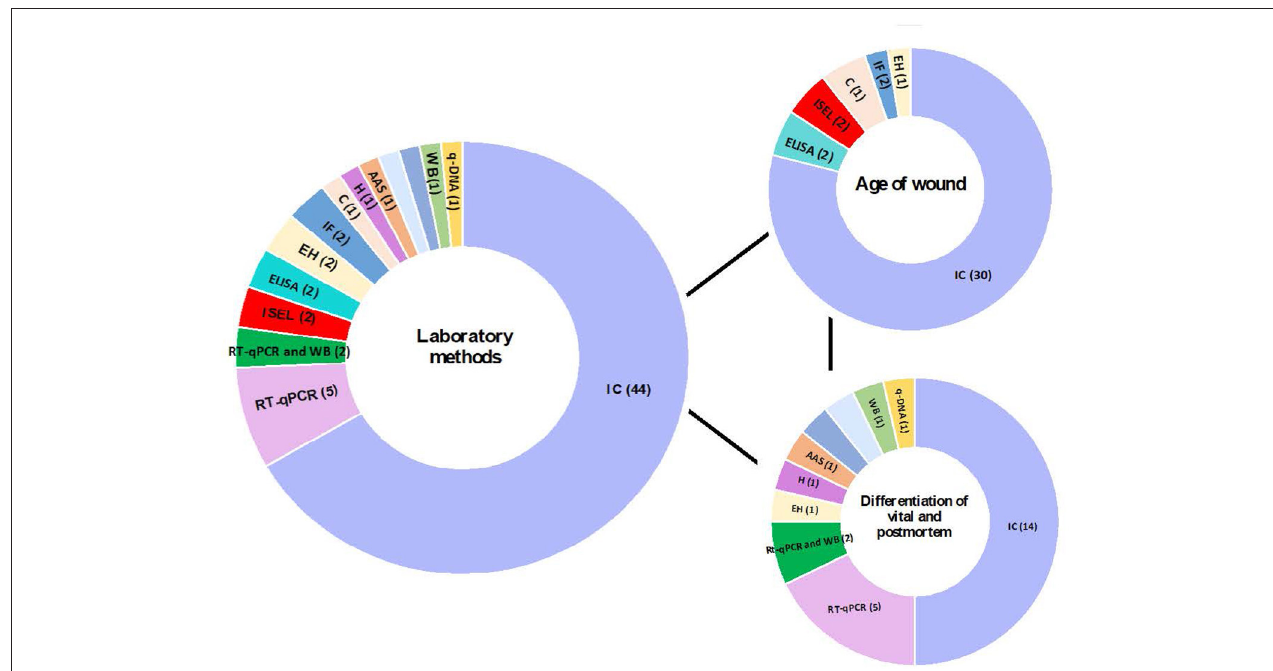
FIGURE 3 | Contribution of different laboratory techniques to the analysis of age of wound and differentiation of vital and post-mortem wound. q-DNA analysis, quantitative DNA analysis; IC analysis, Immunohistochemical Analysis; EH analysis, Enzyme histochemical analysis; WB, western blot; AAS, Atomic absorption spectrometry; H analysis, Histological analysis; HPLC, liquid chromatography; MSI, Multiplex sandwich